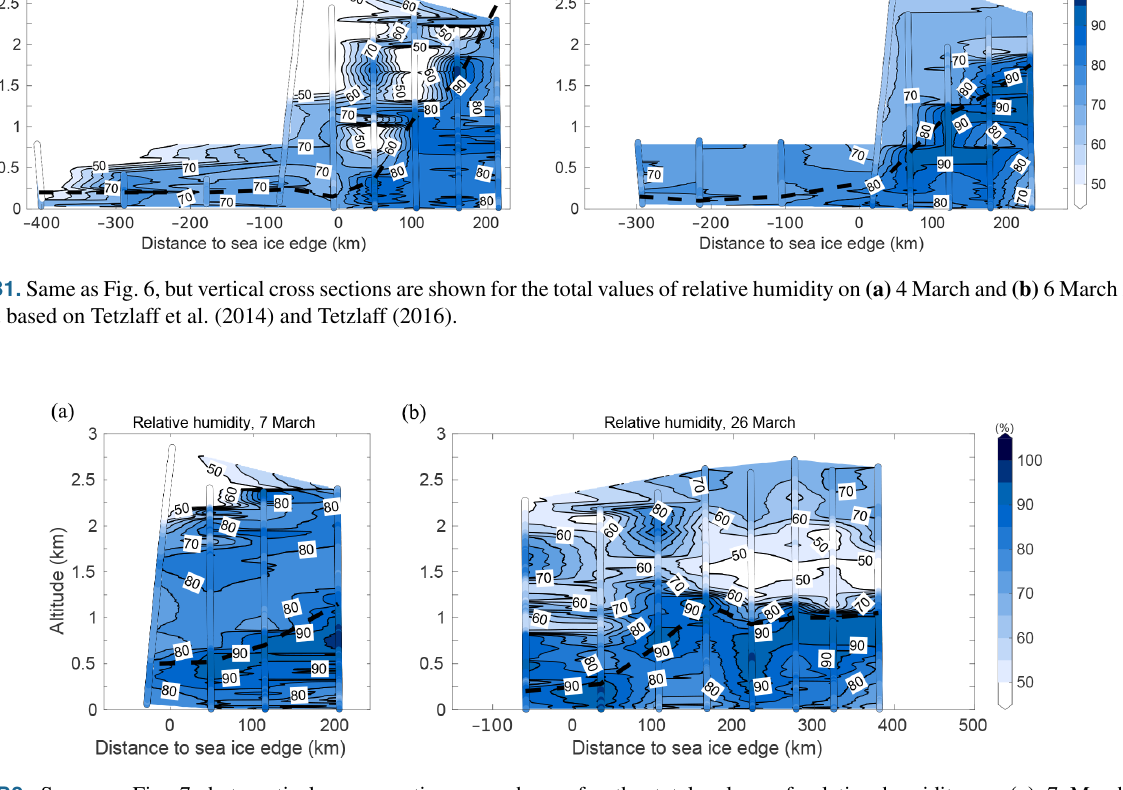
Figure B2. Same as Fig. 7, but vertical cross sections are shown for the total values of relative humidity on (a) 7 March and (b) 26 March 2013. Modified based on Tetzlaff et al. (2014) and Tetzlaff